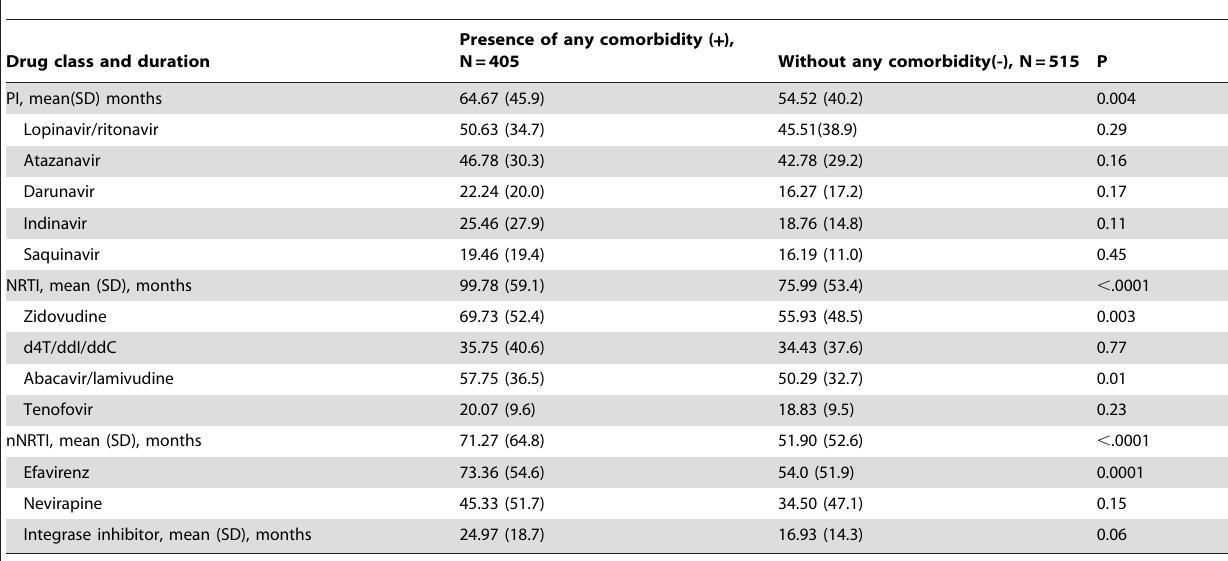
Table 4. The cumulative exposure durations of antiretroviral agents of the two study populations.